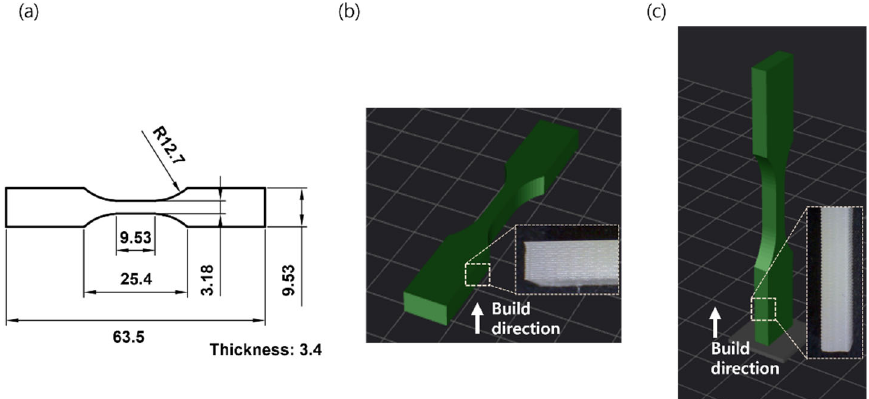
Figure 2. ( a ) Graphical representation of the tensile test specimen specified in the ASTM standard D638-10 (type 5); tensile test specimens printed ( b ) horizontally and ( c ) vertically. Magnified images of the specimens are also shown.